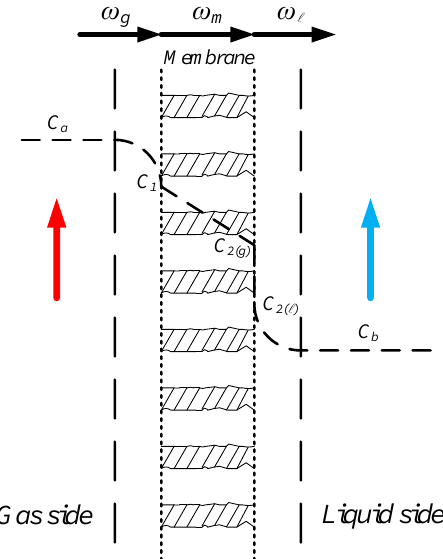
Figure 2. Schematic representation of the CO 2 concentration variation from the gas phase to the liquid phase through the membrane.